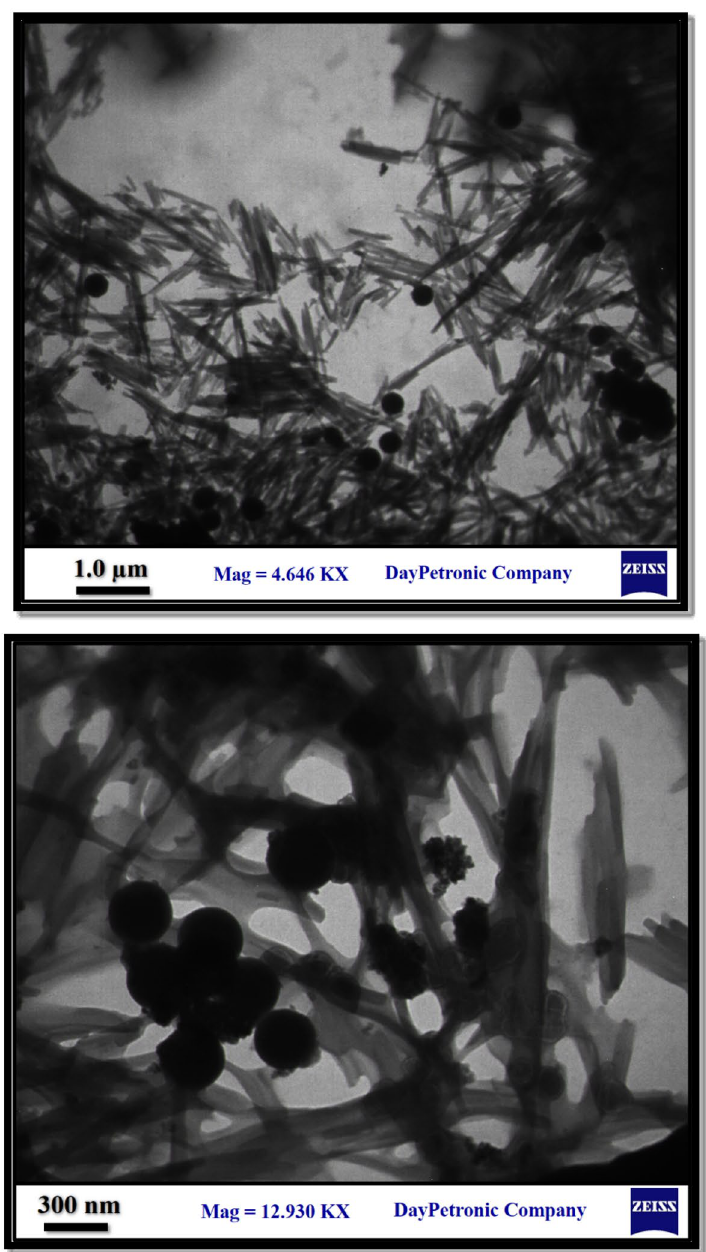
Figure 5. TEM images of the Fe 3 O 4 /SiO 2 -TMA-Me nanomaterial ( 1 ) in 1.0 µm and 300 nm